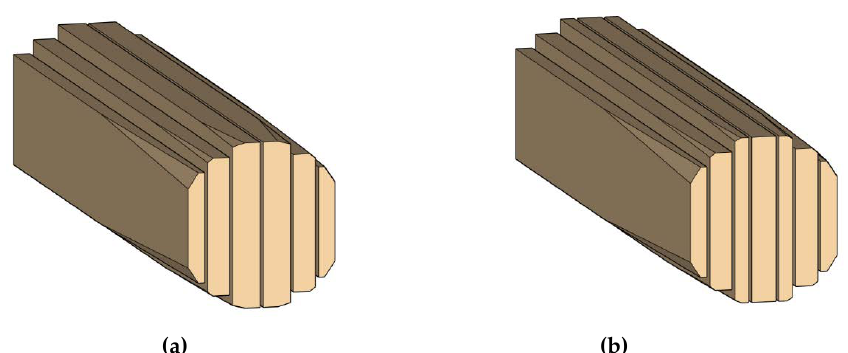
Figure 5. Cutting pattern mode.